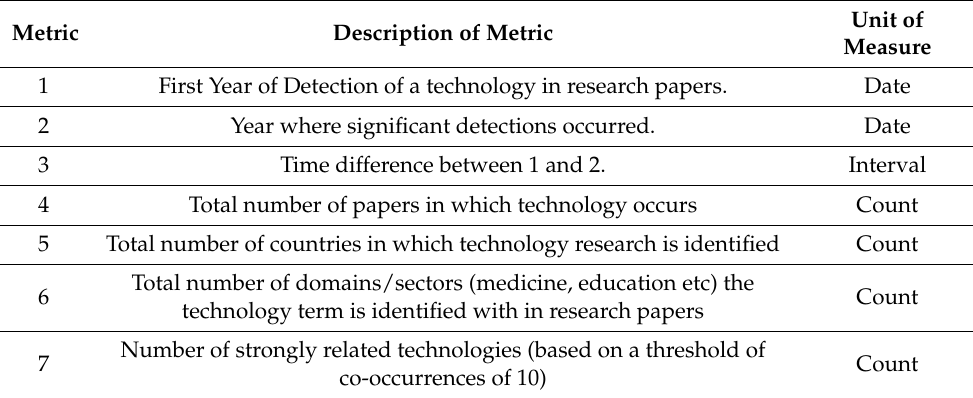
Table 2. Quantitative metrics of technology